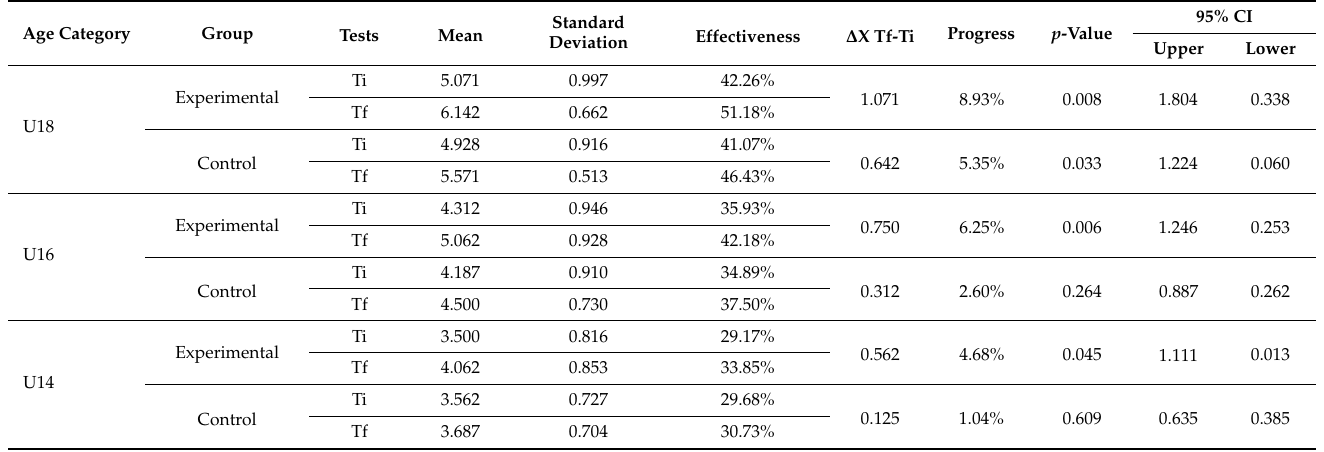
Table 1. Descriptive statistics for the FRB test for the experimental and control male groups U14, U16, and U18.